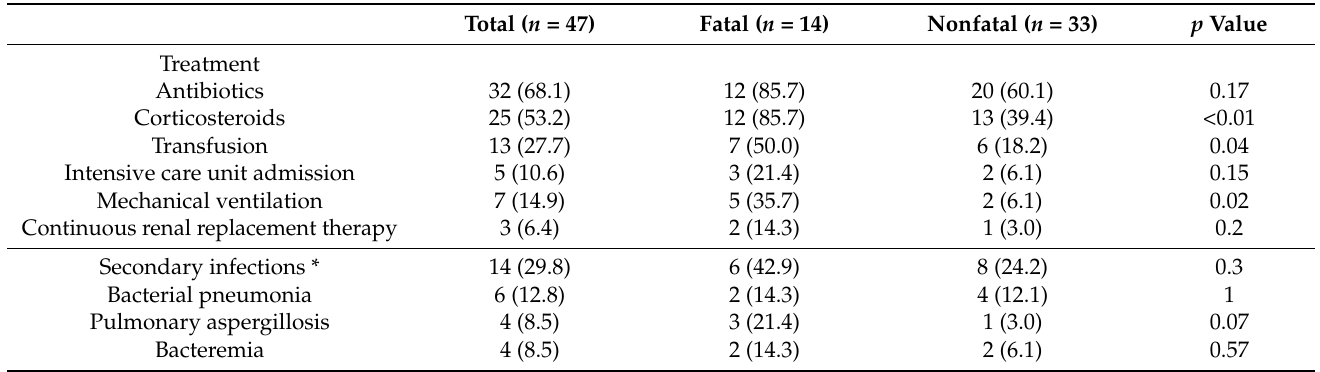
Table 2. Treatment and outcome including complication of secondary